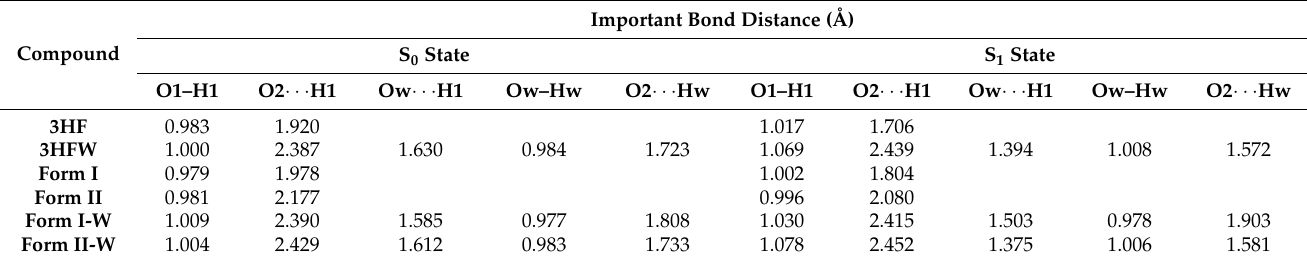
Table 1. A summary of the important bonds and distances involving PT process of enol form for all complexes in the S 0 and S 1 states.